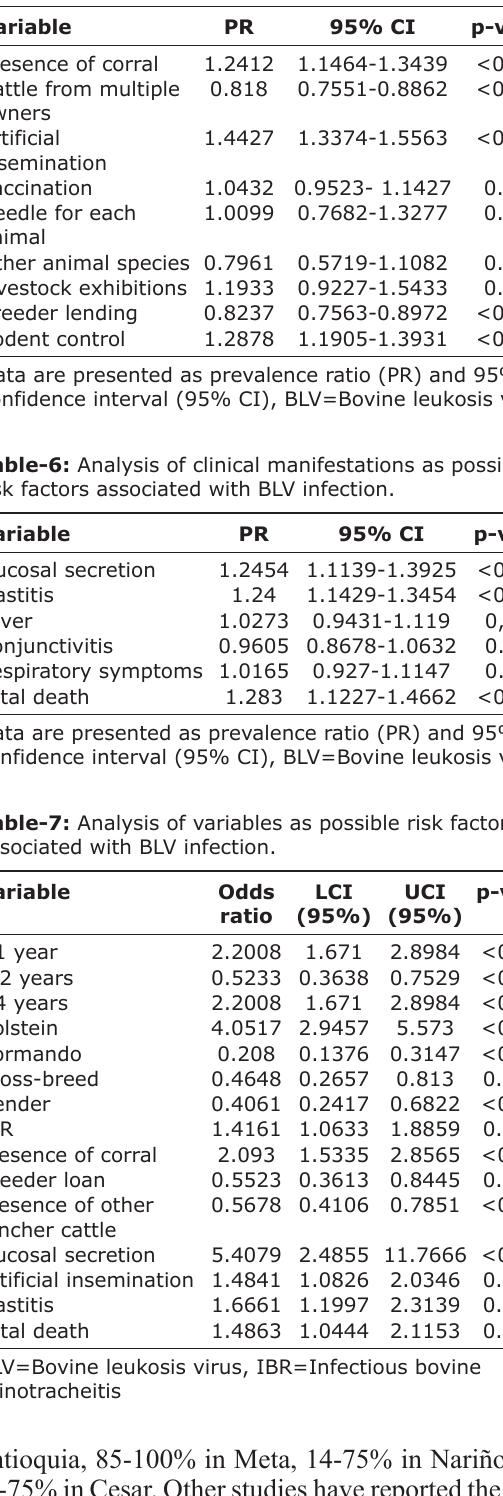
BLV=Bovine leukosis virus, IBR=Infectious bovine